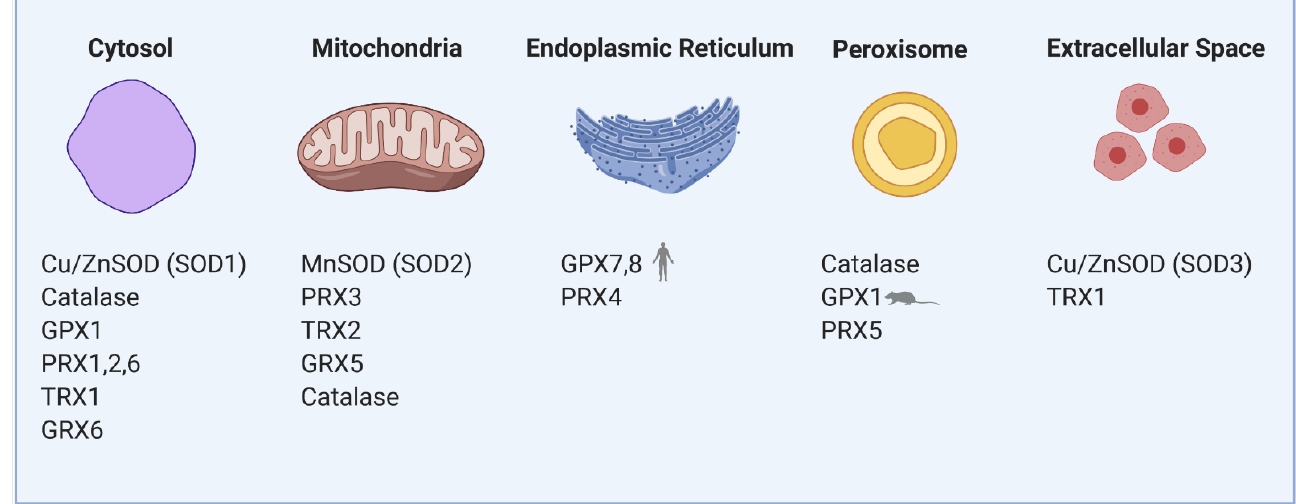
Figure 1. Compartmentalization of redox regulating proteins in β-cells involves mitochondria, cytosol, endoplasmic reticulum (ER), peroxisomes and extracellular space. SOD—superoxide dismutase, GPX—glutathione peroxidase, PRX— peroxiredoxin, TRX—thioredoxin, GRX—glutaredoxin.